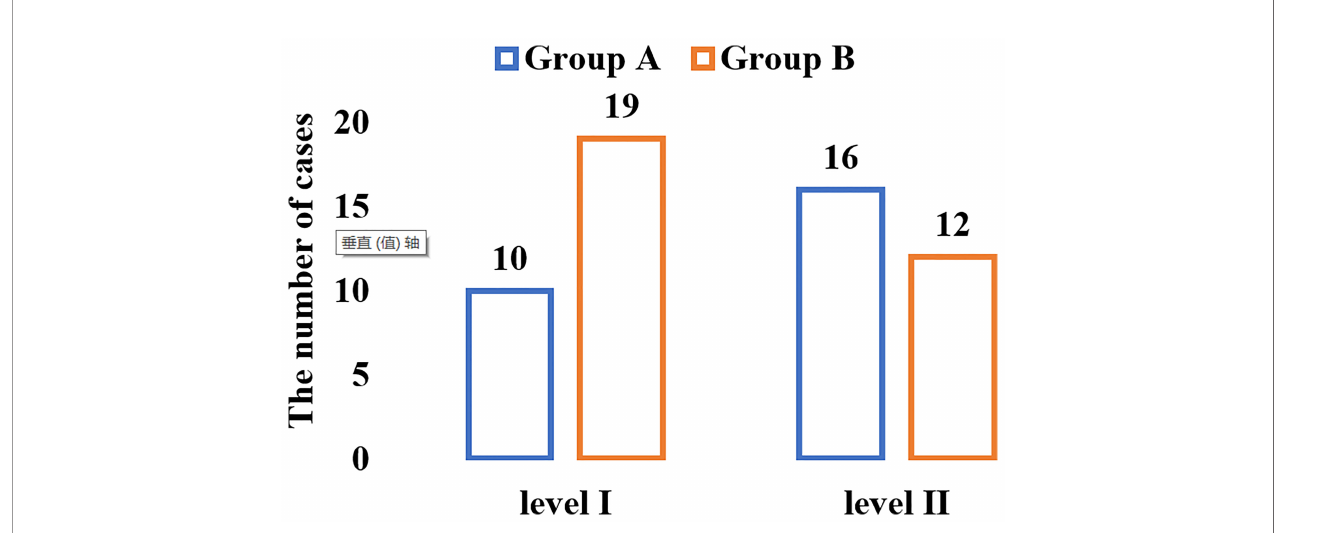
FIGURE 2 | The results of the comparison of the clinical ef fi cacy of the two groups of